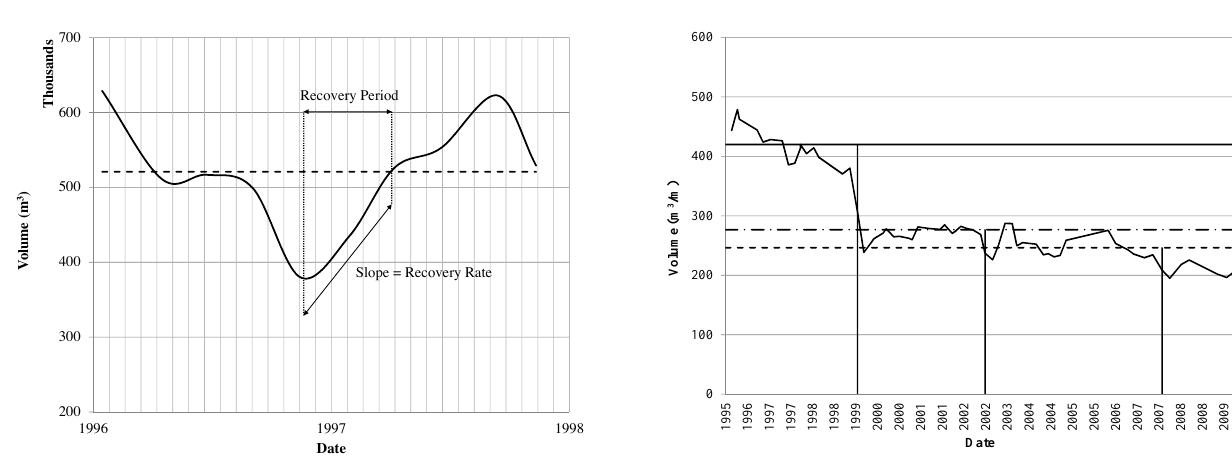
Fig. 5. The moving average volume of profile DN6 in Durban North (–). The average profile levels prior to the following erosion events are shown: 29 June 1999 by the solid line; 4 December 2002 by the dashed and dotted line; 12 September 2007 by the dashed